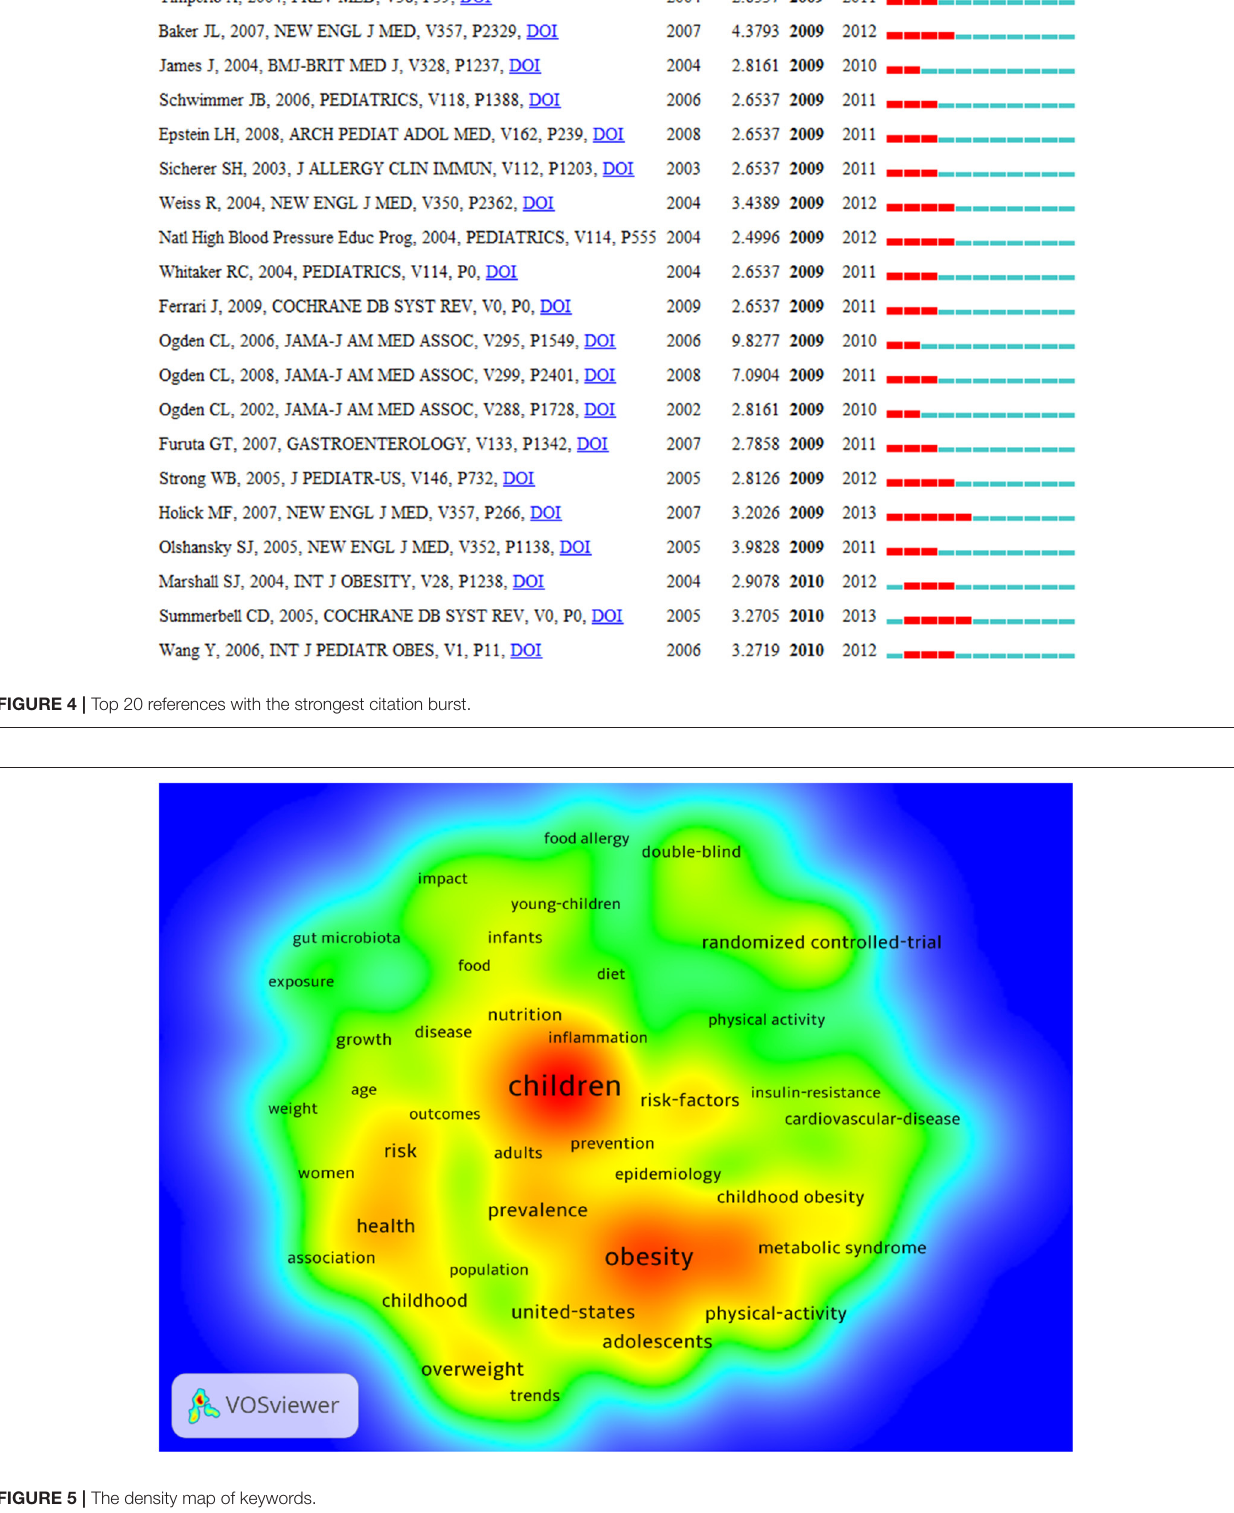
FIGURE 5 | The density map of